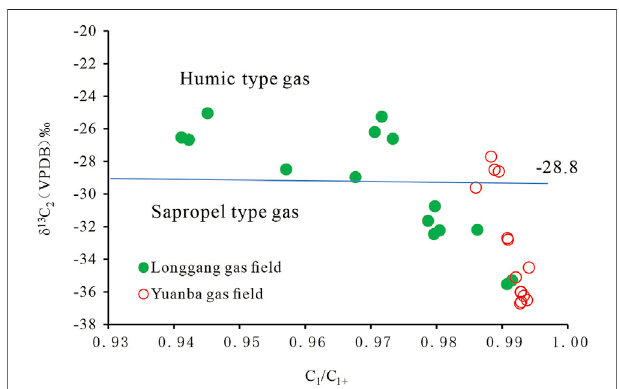
FIGURE 8 | Relationship between C 1 /C 1+ and δ 13 C 2 of T 2 l 4 gas in Longgang and Yuanba gas fi elds.